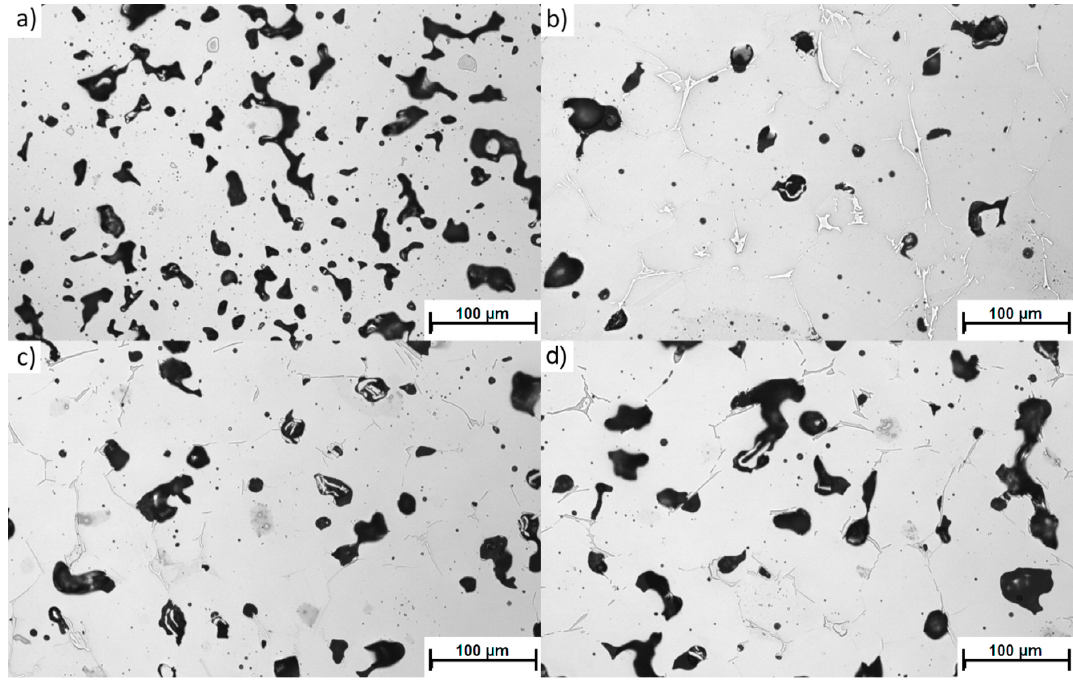
Figure 4. Representative porosity microstructure of samples: ( a ) 0-0; ( b ) 4-0; ( c ) 4-4; and ( d ) 4-8.